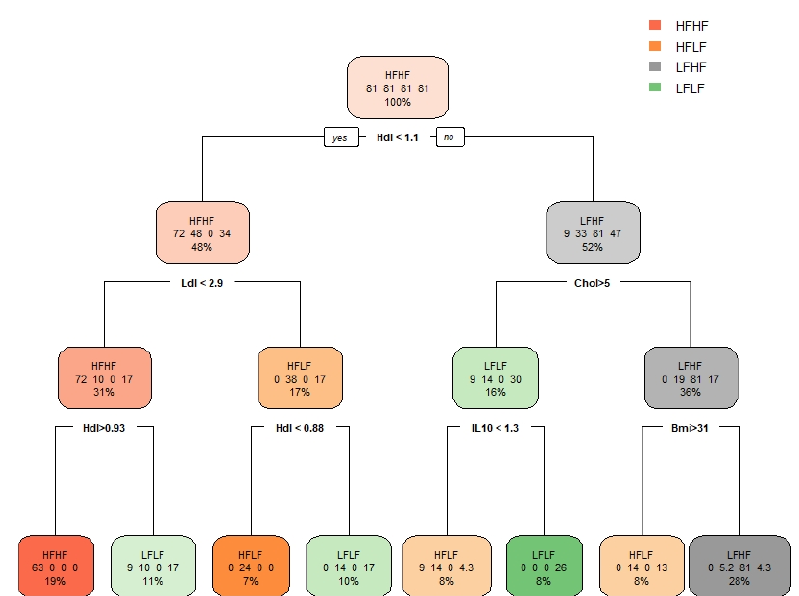
Figure 5. Decision tree, where HDL = High Density Lipoprotein, LDL = Low Density Lipoprotein, IL-10 = Interleukin-10 and BMI = Body Mass Index are expressed in their original dimensions (mmol/L, mmol/L, pg/mL, respectively). HFHF = Higher-Fatness with Higher-Fitness group, HFLF = Higher-Fatness with Lower-Fitness group, LFHF = Lower-Fatness with Higher-Fitness group, LFLF = Lower-Fatness with Lower -Fitness group.